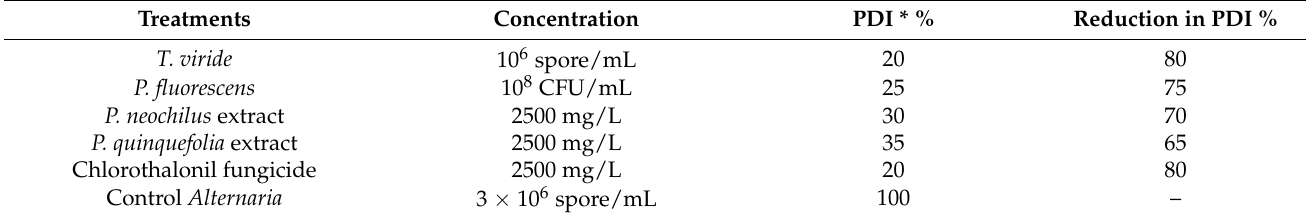
Table 5. Efficacy of bio-agents, plant extracts, and chemical fungicide tested as foliar spray on severity of early blight disease.